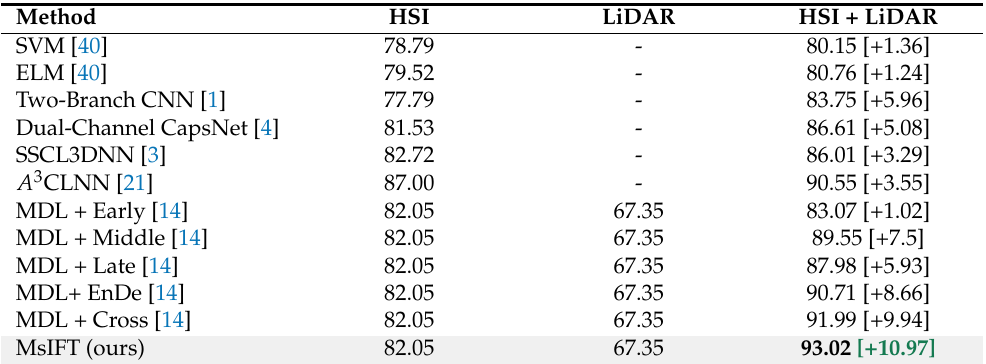
Table 5. Performance comparison on HS–LIDAR